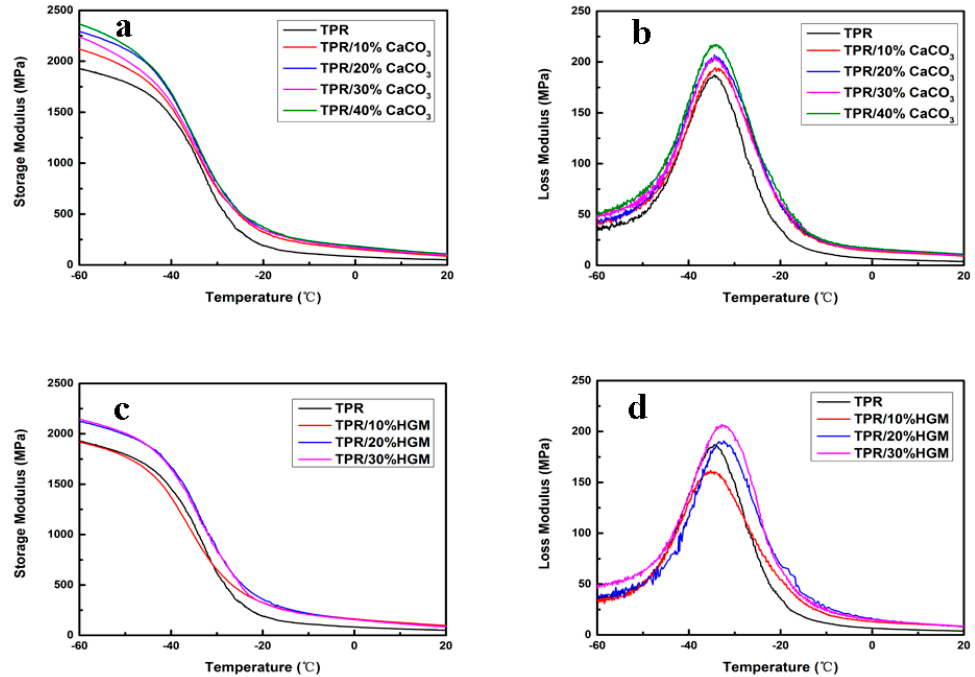
Figure 5. ( a ) Storage modulus ( E ′ ) of TPR/CaCO 3 composites; ( b ) loss modulus ( E ″ ) of TPR/CaCO 3 Figure 5. ( a )Storagemodulus( E (cid:48) )ofTPR/CaCO 3 composites; ( b )lossmodulus( E ”)ofTPR/CaCO 3 composites; composites; ( c ) storage modulus ( E ′ ) of TPR/HGM composites; ( d ) loss modulus ( E ″ ) of TPR/HGM ( c ) storage modulus ( E (cid:48) ) of TPR/HGM composites; ( d ) loss modulus ( E ”) of TPR/HGM composites.